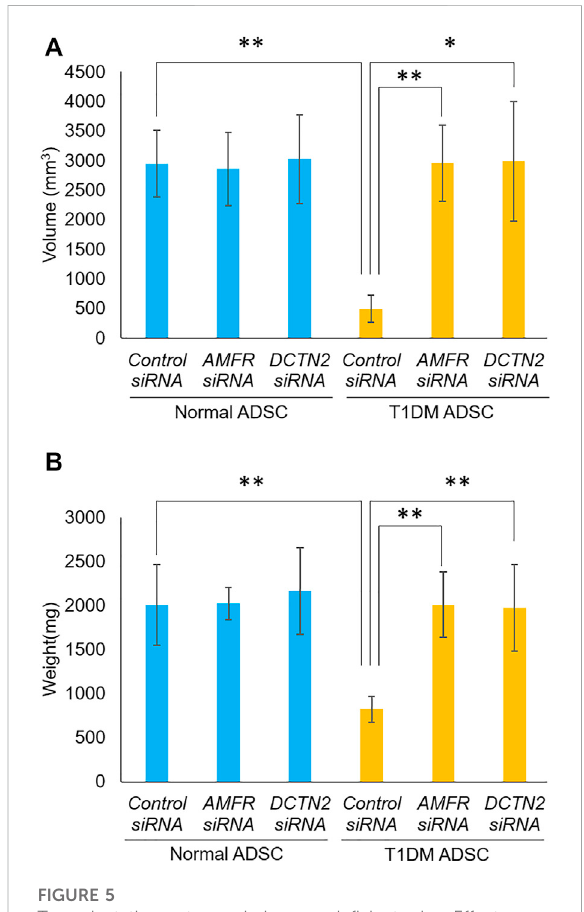
FIGURE 5 Transplantation outcome in immunode fi cient mice. Effects of AMFR and DCTN2 on stem cell transplantation ef fi ciency. (A) Graft volume (mm 3 ) 2 weeks after stem cell transplantation. (B) Graft weight (mg) 3 weeks after stem cell transplantation. (A) The p -value were 0.8883 (Normal ADSCs Control siRNA vs. Normal ADSCs AMFR siRNA), 0.9075 (Normal ADSCs Control siRNA vs. Normal ADSCs DCTN2 siRNA), 0.0072 (T1DM ADSCs ControlsiRNAvs.T1DMADSCs AMFR siRNA),0.0273(T1DMADSCs Control siRNA vs. T1DM ADSCs DCTN2 siRNA), 0.0046 (Normal ADSCs Control siRNA vs. T1DM ADSCs Control siRNA), 0.888 (Normal ADSCs AMFR siRNA vs. T1DM ADSCs AMFR siRNA), 0.9663(Normal ADSCs DCTN2 siRNA vs. T1DM ADSCs DCTN2 siRNA). (B) The p -valuewere0.9641(NormalADSCsControlsiRNA vs. Normal ADSCs AMFR siRNA), 0.7603 (Normal ADSCs Control siRNA vs. Normal ADSCs DCTN2 siRNA), 0.0021 (T1DM ADSCs Control siRNA vs. T1DM ADSCs AMFR siRNA), 0.0081 (T1DM ADSCs Control siRNA vs. T1DM ADSCs DCTN2 siRNA), 0.009 (Normal ADSCs Control siRNA vs. T1DM ADSCs Control siRNA), 0.9542(NormalADSCs AMFR siRNAvs.T1DMADSCs AMFR